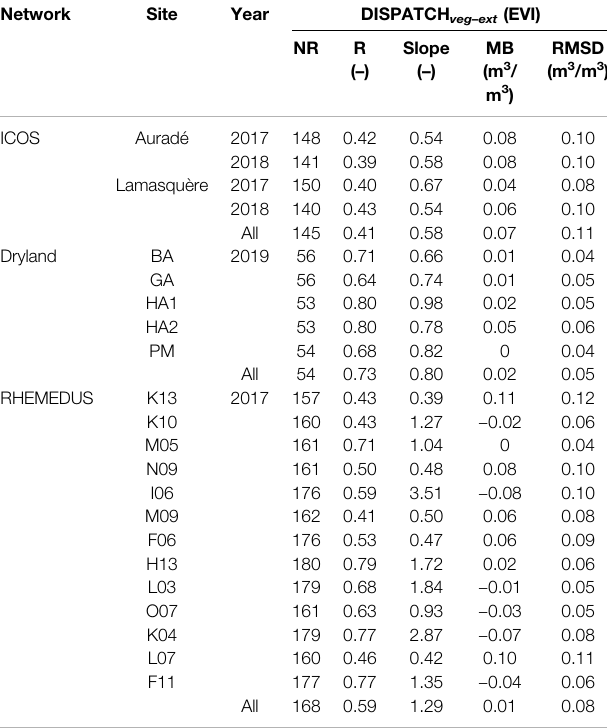
NR, Number of retrieval.